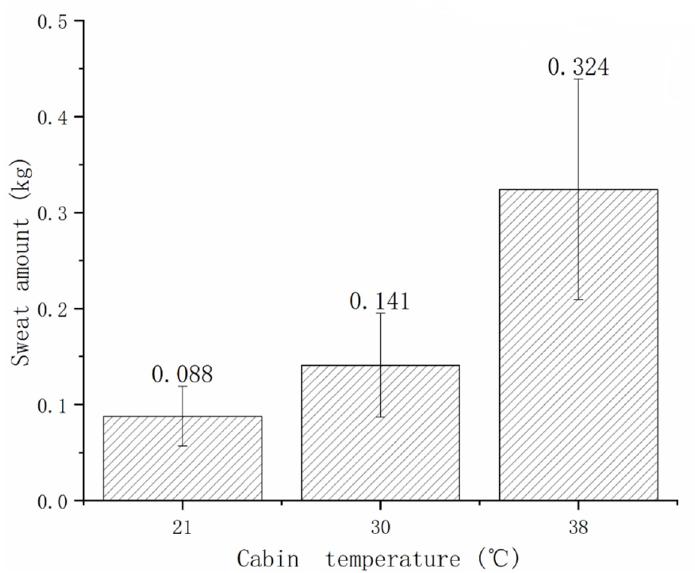
Figure 7. Sweat amounts at various ambient temperatures.